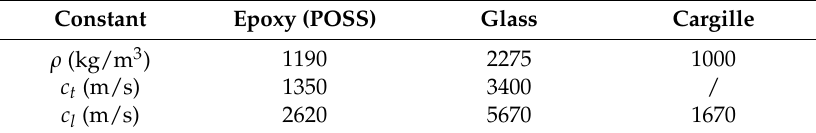
Table 1. Density ( ρ ), transverse ( c t ), and longitudinal ( c l ) velocities of sound used in the calculation. Constant Epoxy (POSS) Glass